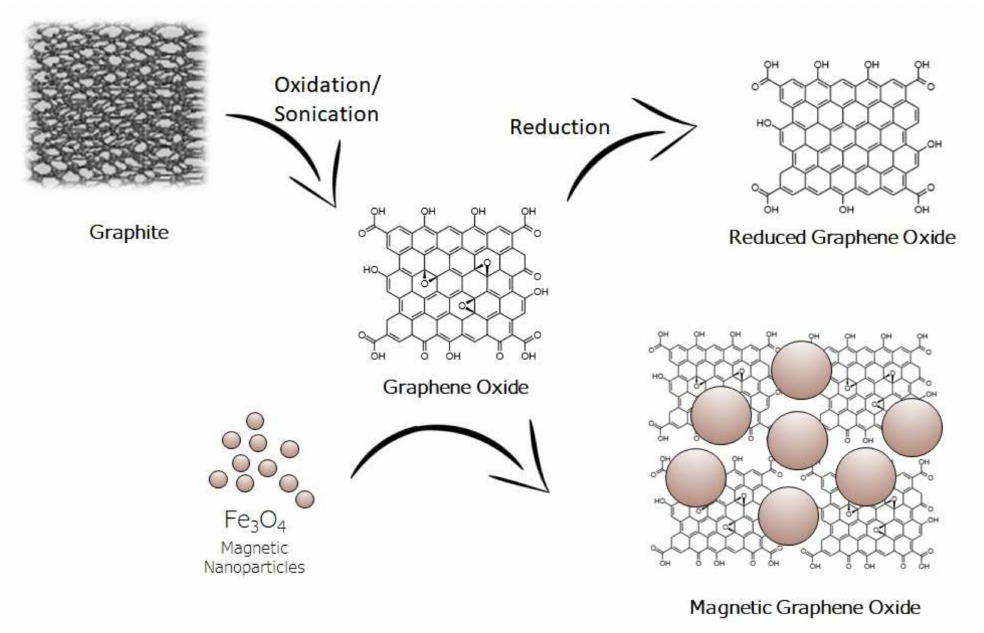
Figure 1. Structure of graphite, graphene oxide, reduced graphene oxide, and magnetic graphene